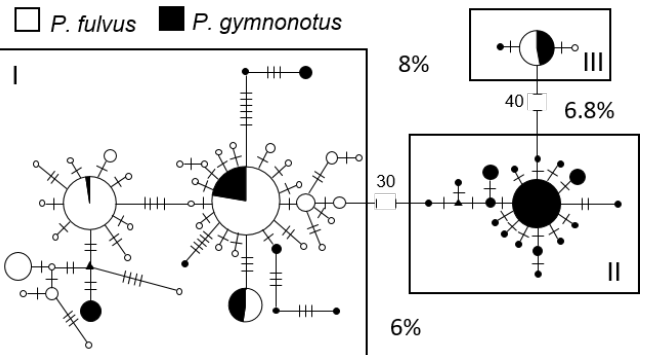
Figure 5. mtDNA haplotype networks for Pteronotus fulvus and P. gymnonotus indicating the three haplogroups ( I , II and III ). Small lines connecting haplotypes denote the mutational steps between them. Black, small triangles represent hypothetical haplotypes and the size of each circle repre- sents the frequency of different haplotypes. Percentage values indicate genetic distance among haplotype groups.